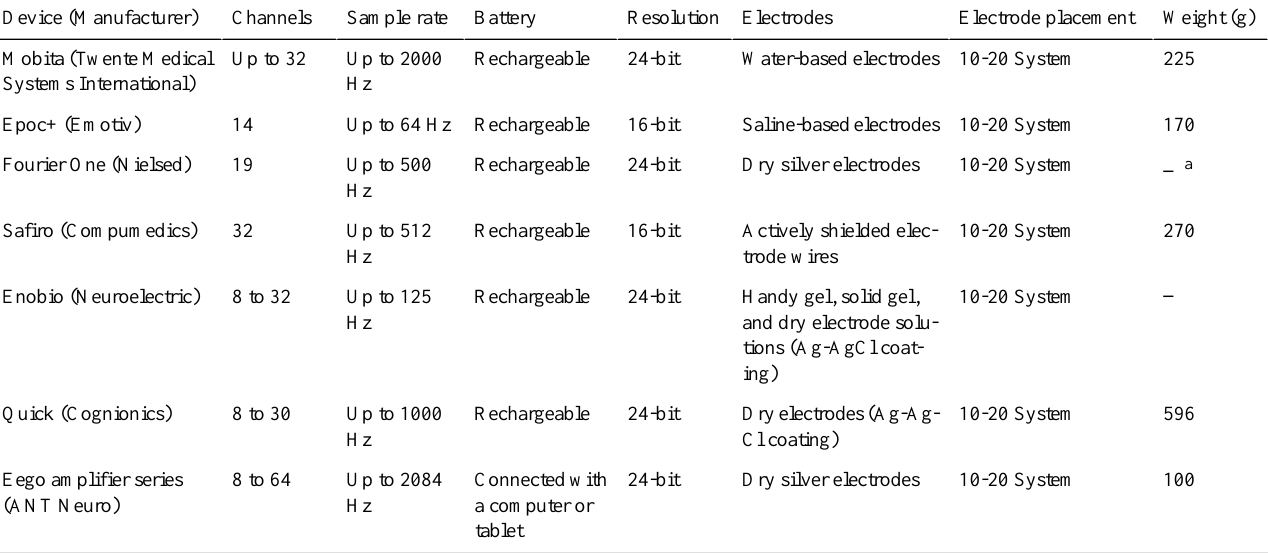
Table 1. Specifications of commercially available EEG portable solutions for diagnostic or research purposes.